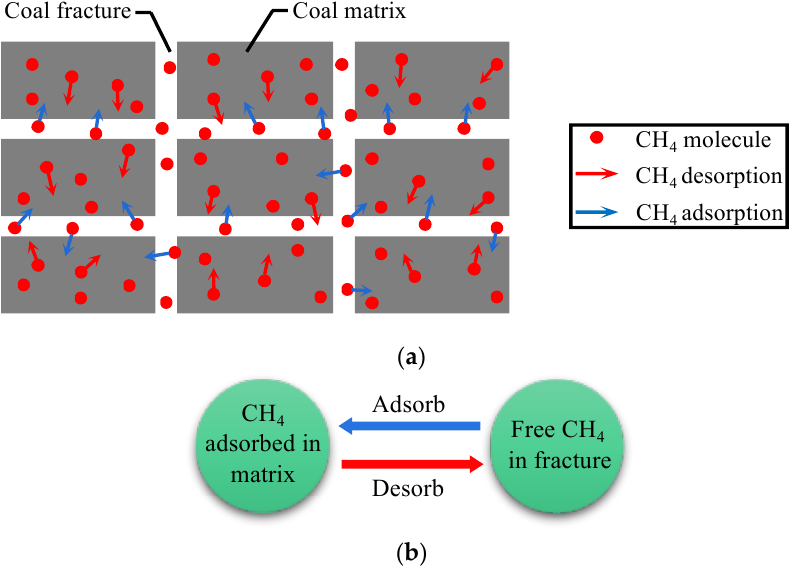
Figure 1. The original state of coal seam gas: ( a ) Schematic diagram of the gas equilibrium process; ( b ) Illustration of the mechanism.